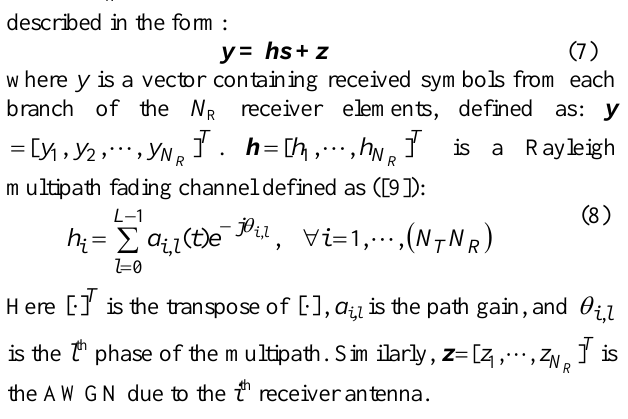
Figure 1: Schematic example of an MRC scheme In the transmitter, randomly generated symbols, a , are mapped using BPSK. The resulting symbols are transmitted  hh ,, over 1 R N zz ,, 1 R N